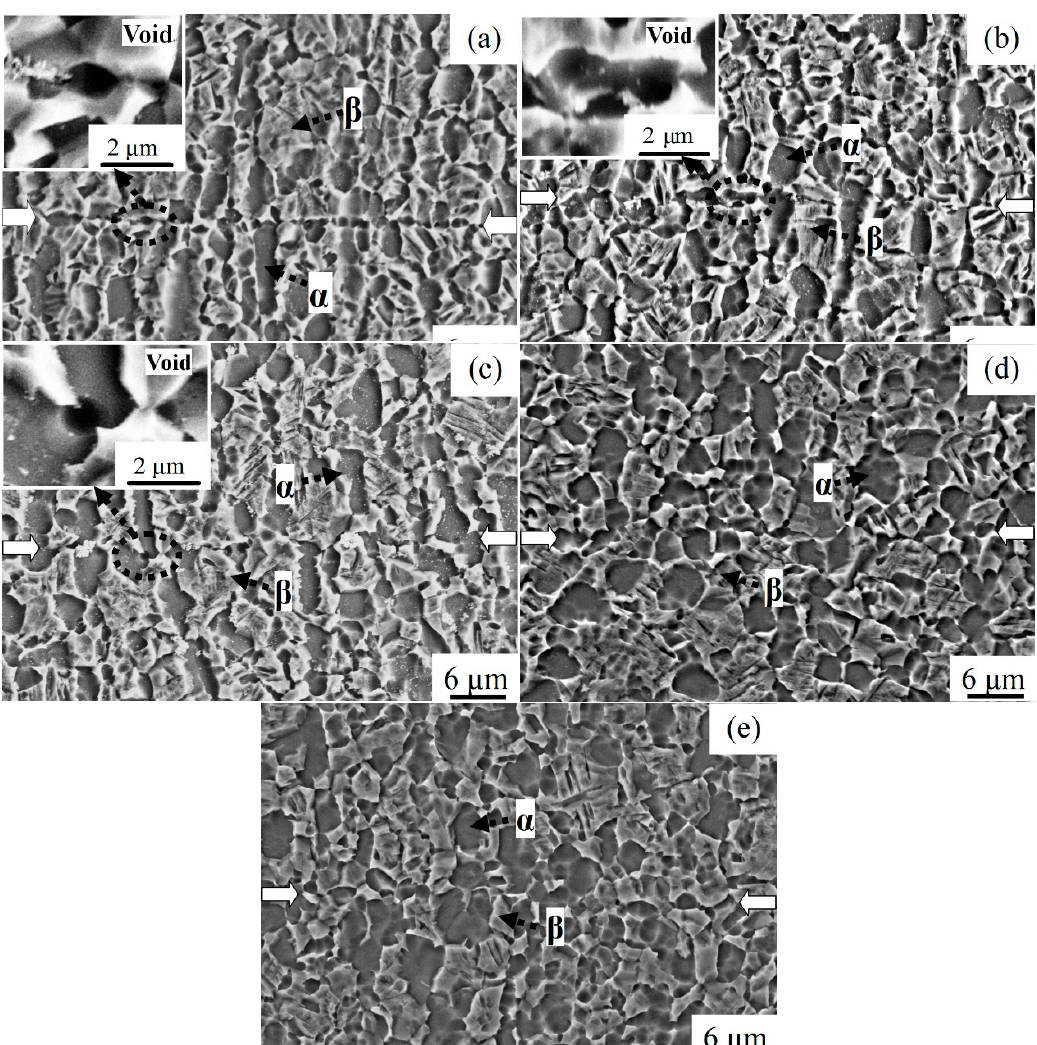
Figure 6. Microstructure morphology of the Ti–5Al–2Sn–2Zr–4Mo–4Cr alloy bond obtained at different times: ( a ) 1 min; ( b ) 3 min; ( c ) 5 min; ( d ) 10 min; ( e ) 20 min.